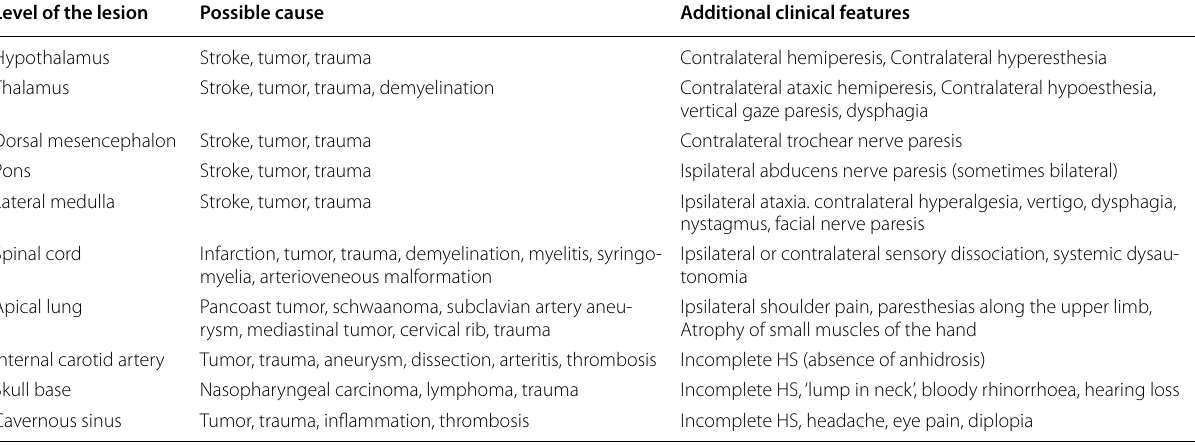
Table 1 Causes and clinical manifestations with respect to level of lesion for Horner’s syndrome (derived from multiple sources [1, 4,